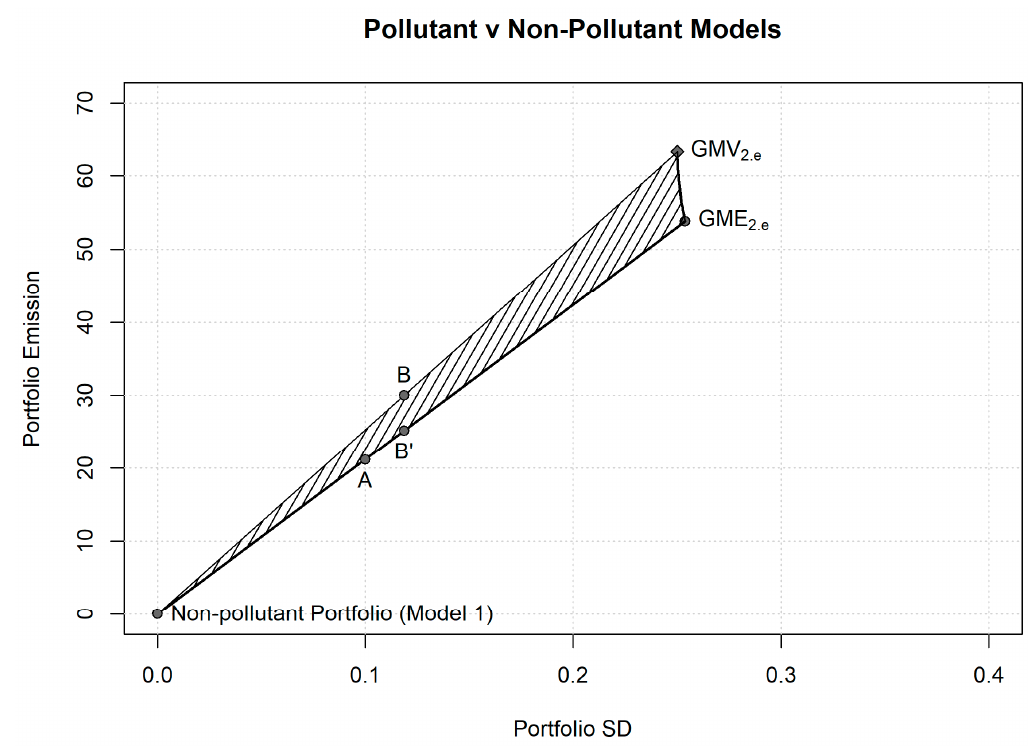
Figure 9. A Capital Market Line (CML)-Analogous analysis.